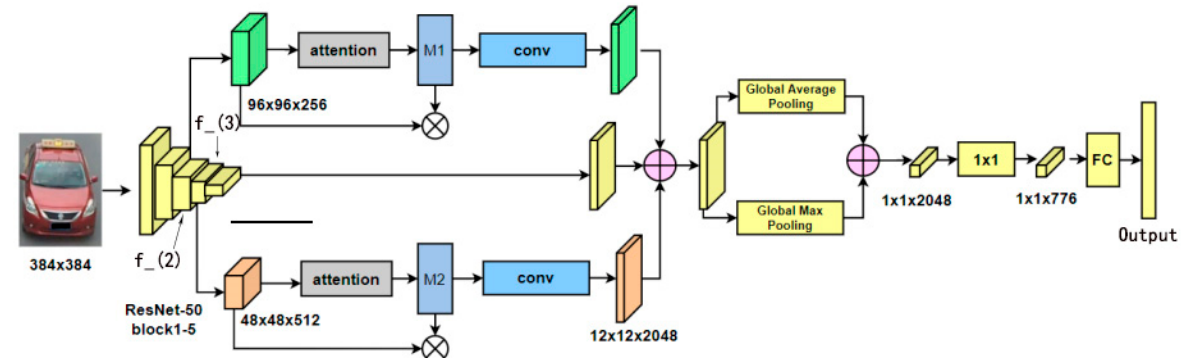
Figure 2. Global branch vehicle feature extraction model integrating hybrid a tt ention